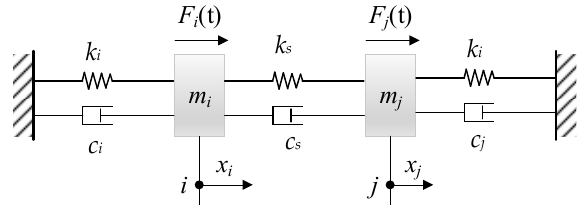
Figure 5. Spring-mass-damping system.